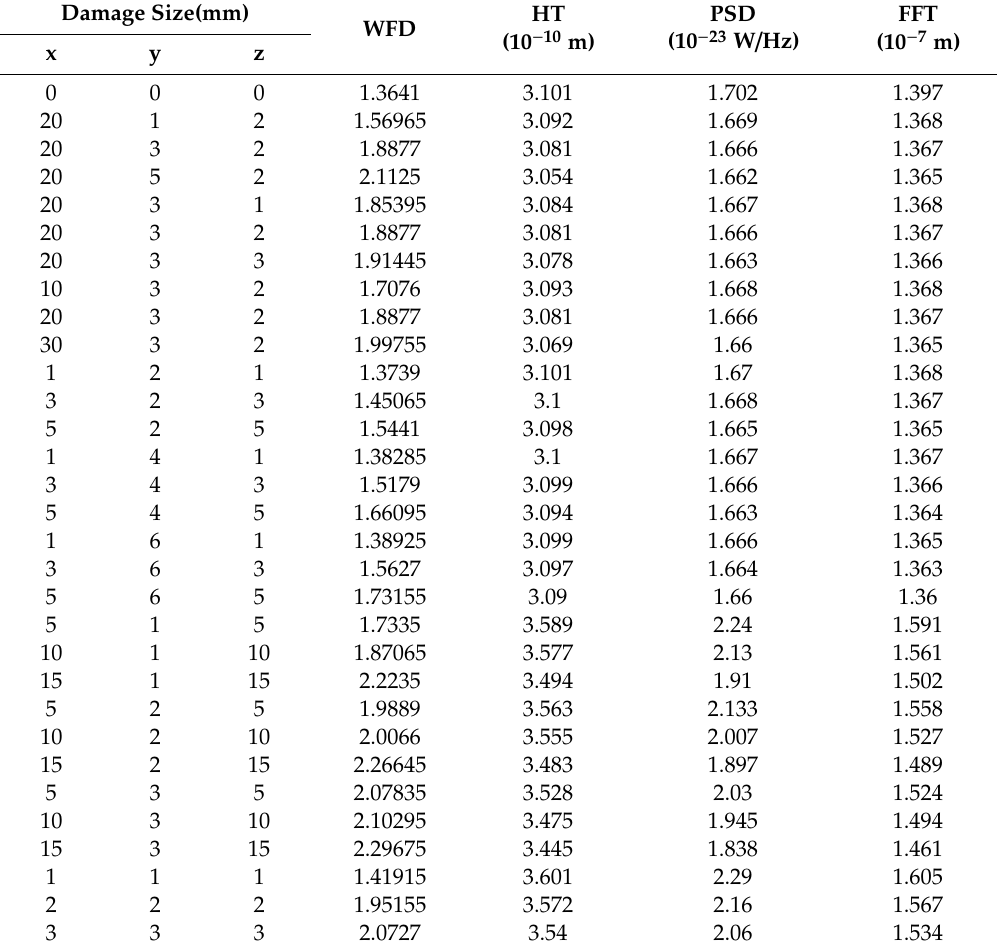
Table 1. Feature extraction results of di ff erent damage types.